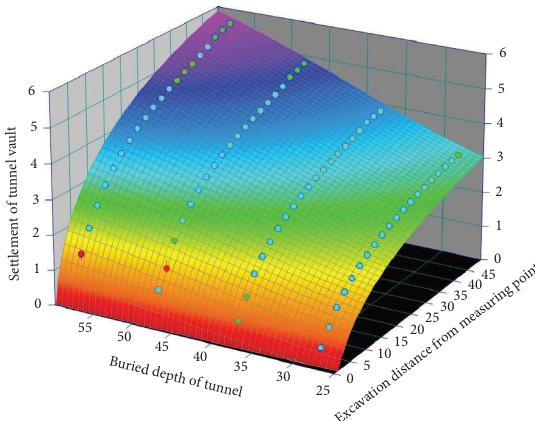
Figure 9: 3D model of tunnel vault settlement model I. Figure